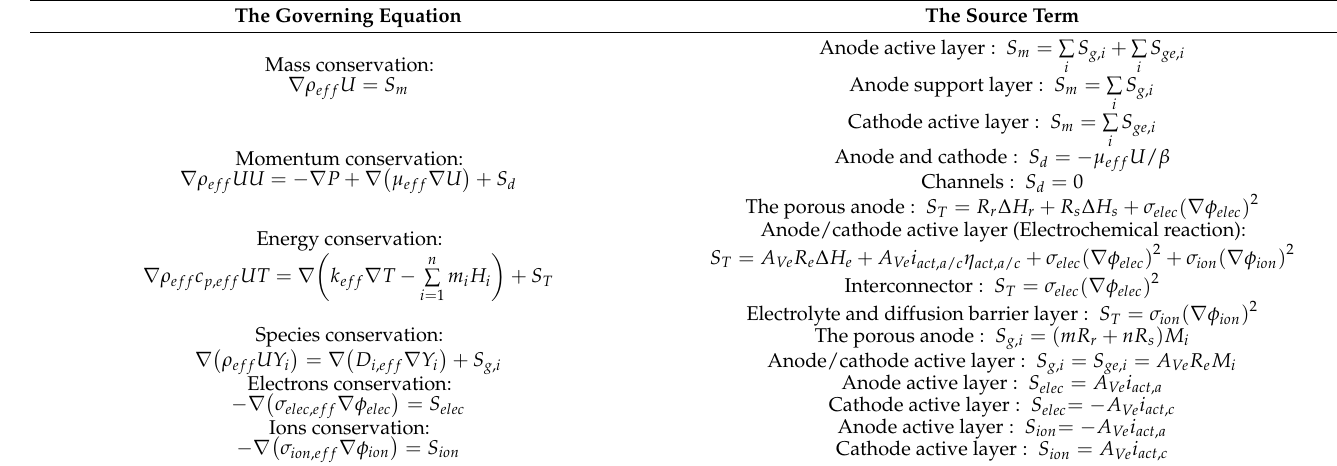
Table 2. Governing equations and corresponding source terms of SOFC model [1–3,9]. The Governing